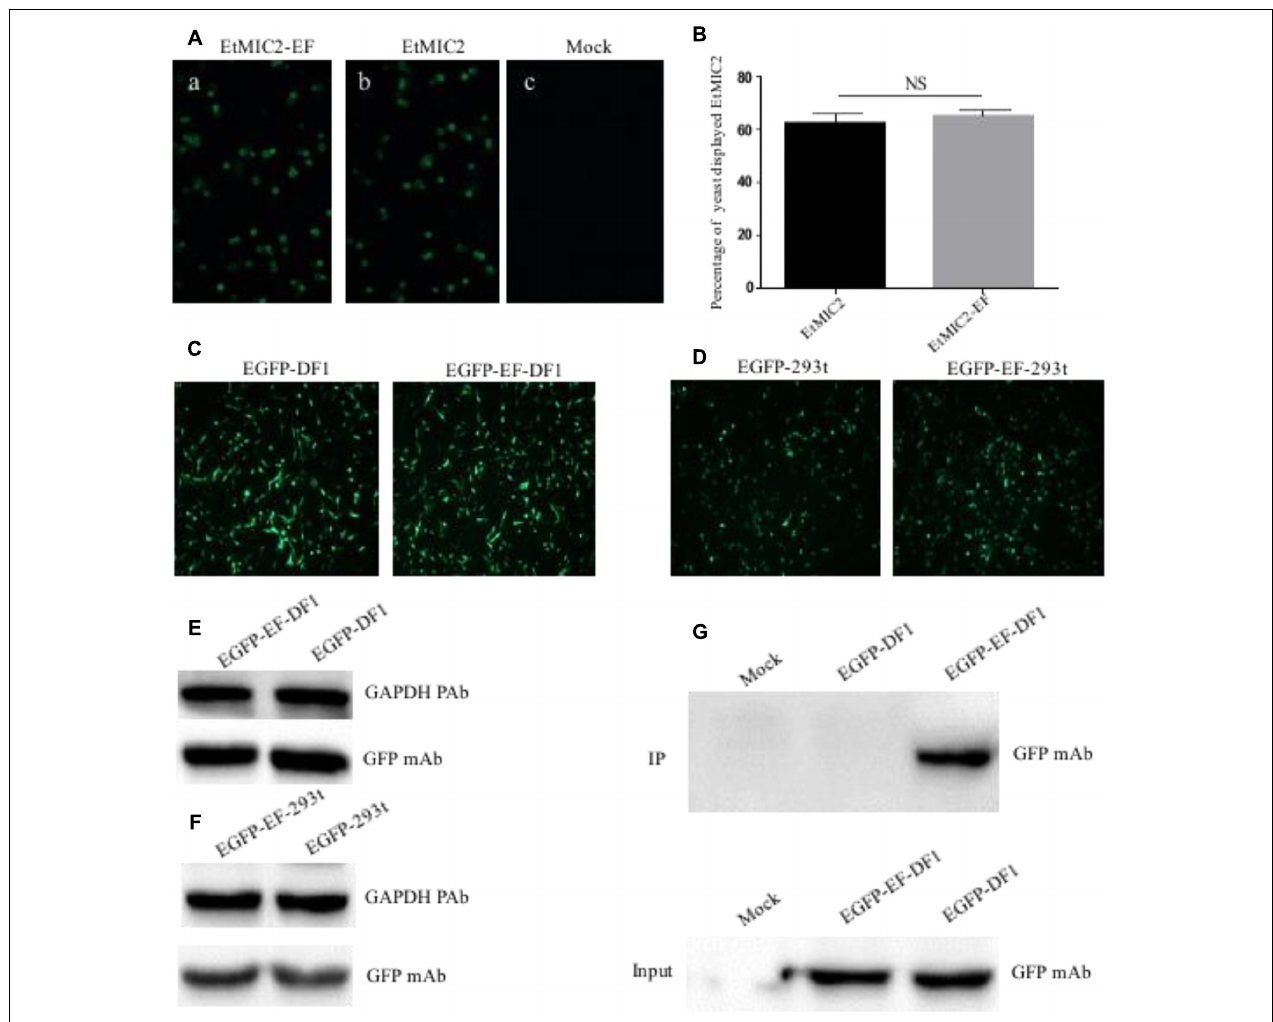
FIGURE 6 | Detection and immunoprecipitation (IP) of EF tag fused protein in yeast, human embryonic kidney cells (HEK-293) and chicken fibroblast cell line (DF1). (A) Immunofluorescence analysis of EtMIC2-EF (a) and EtMIC2 (b) were expressed in yeast cells, using anti-EtMIC2 McAb as primary antibody. Yeast transfected with empty vector as control (c) . (B) Analyzed quantitative expression of EtMIC2-EF and EtMIC2 on the yeast cells surface by flow cytometry. NS, not significant ( p > 0.05). (C) DF1 cells transfected with pEGFP–C1 and pEGFP–EF showed obvious fluorescence signals at 36 h post-transfection. (D) HEK-293 cells transfected with pEGFP–C1 and pEGFP–EF showed obvious fluorescence signals at 36 h post-transfection. (E,F) The level of expression in DF1 cell or HEK-293 transfected with pEGFP–C1 and pEGFP–EF was detected by western blot using anti-GFP McAb. GAPDH is loading control. (G) IP of analysis of transfected cell lysates